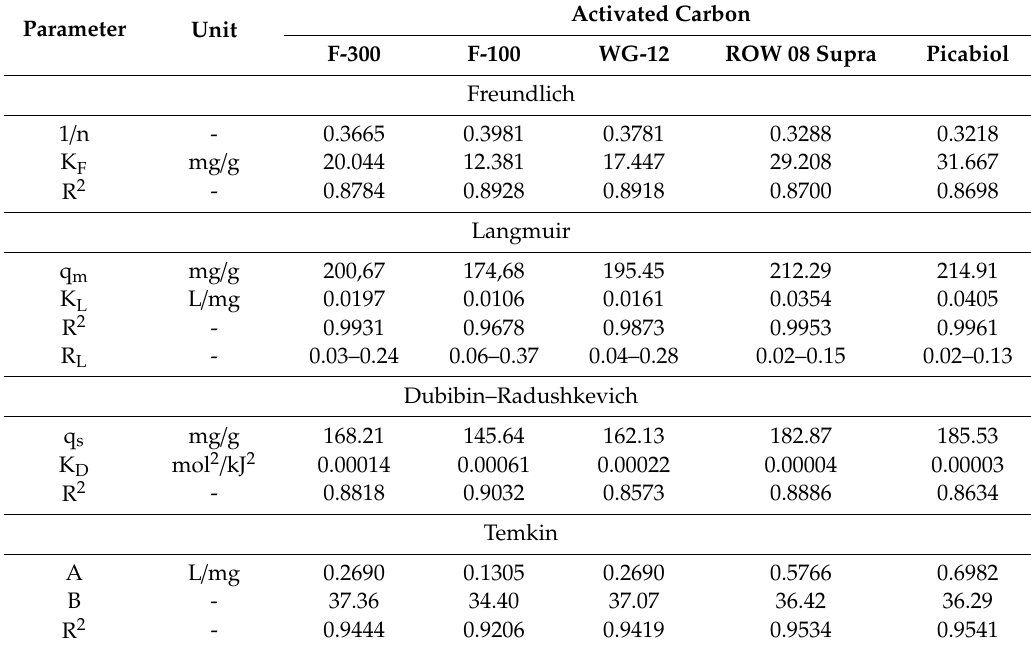
Table 6. Constants for isotherms of chloramphenicol adsorption on commercial activated carbons.